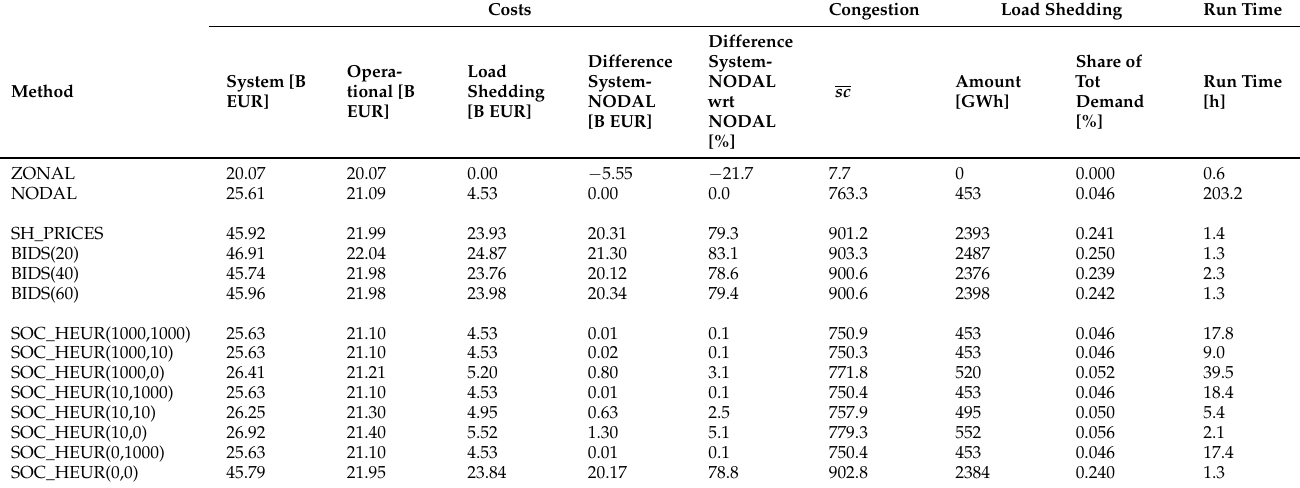
Table 2. Results overview for the short-time horizon benchmark with transmission capacity factor β = 0.5. Reported are for the different methods: the total system costs, which are made up of operational costs (i.e., power generation costs) and load shedding costs, the difference between NODAL and the respective method in absolute amount and relative to the total system costs of NODAL ; the average system congestion ( sc ); the total amount of load shed and the share of this amount with respect to the total load; and the run